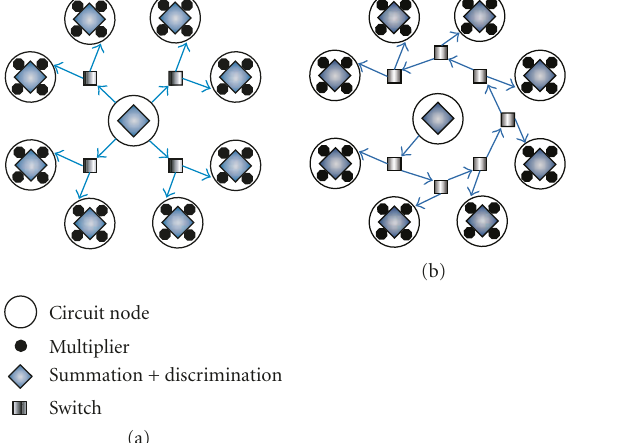
Figure 12: Adder trees combine the network in the producer